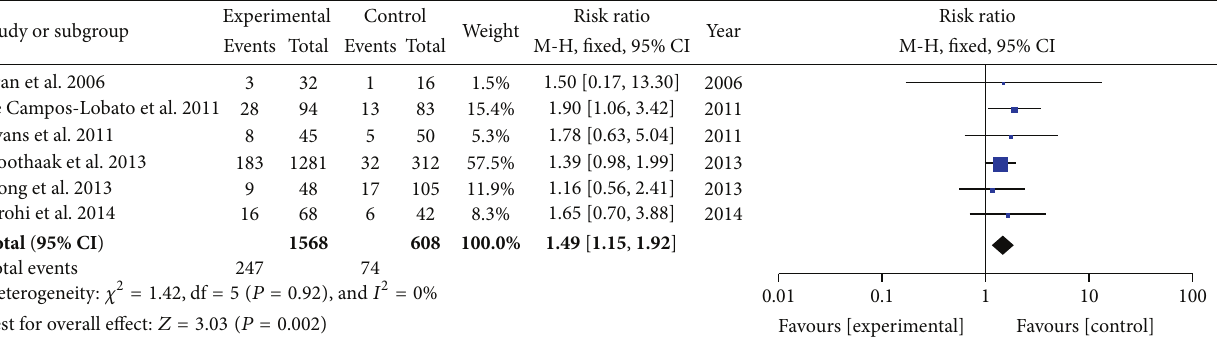
Study or subgroup